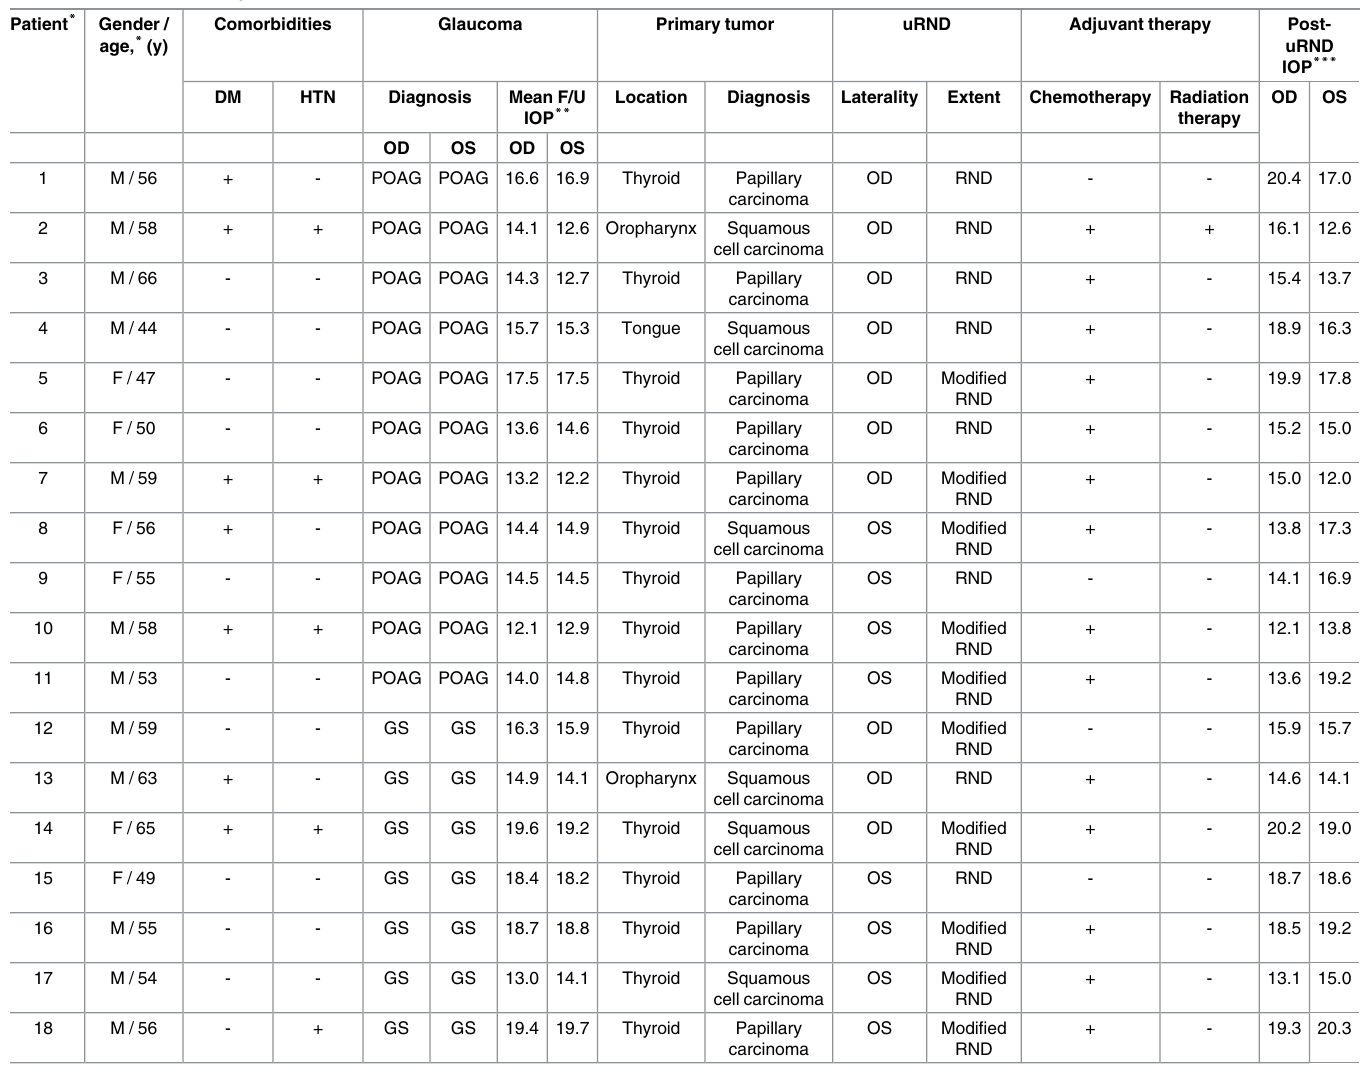
Table 4. Patient